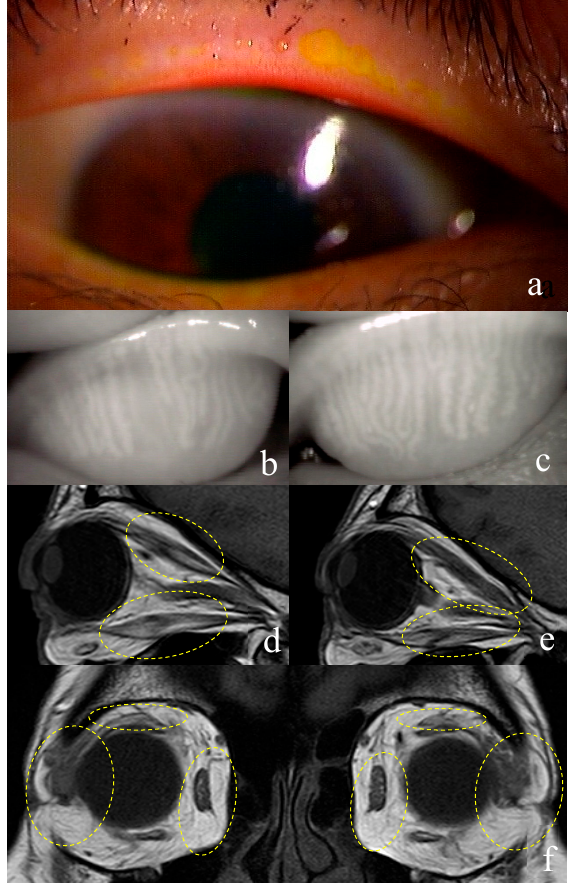
Figure 2. Representative case of a 56-year-old woman with Graves’ ophthalmopathy. The patient presented with lid-margin inflammation ( a ). The meibomian glands in the central region of the upper eyelid exhibit abnormal findings ( b , c ). Magnetic resonance imaging findings show ( d , e ) levator muscle and superior and inferior rectus muscle enlargement, as well as ( f ) medial rectus muscle enlargement and swelling of the lacrimal glands.